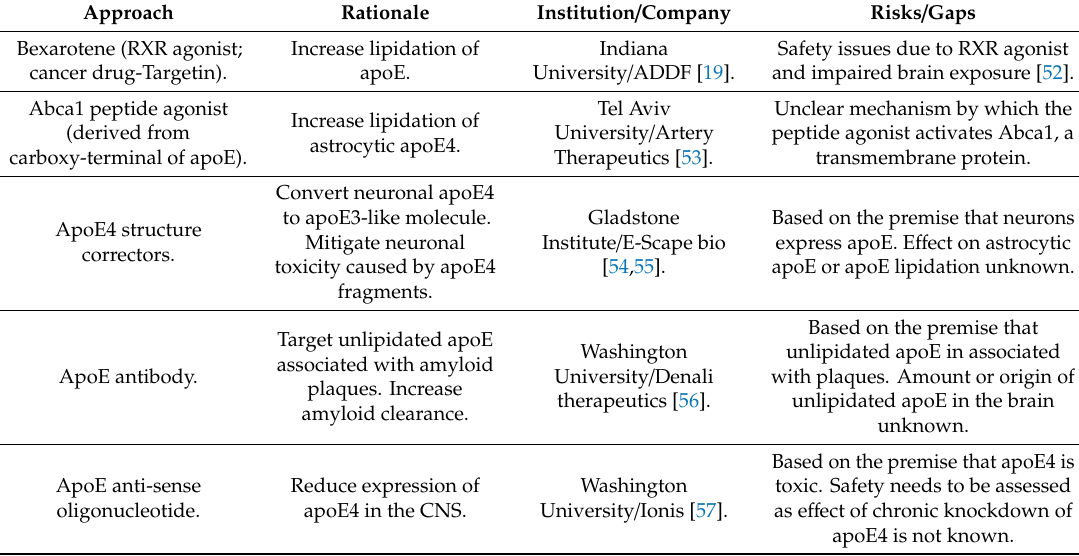
Table 1. Overview of approaches for targeting apolipoprotein E (apoE) for Alzheimer’s disease (AD).